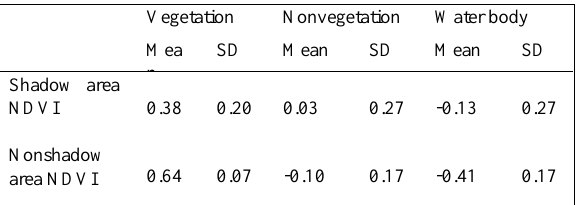
Table 5. Descriptive statistics of vegetation indexes of the shadow and non-shadow areas for the various land cover types